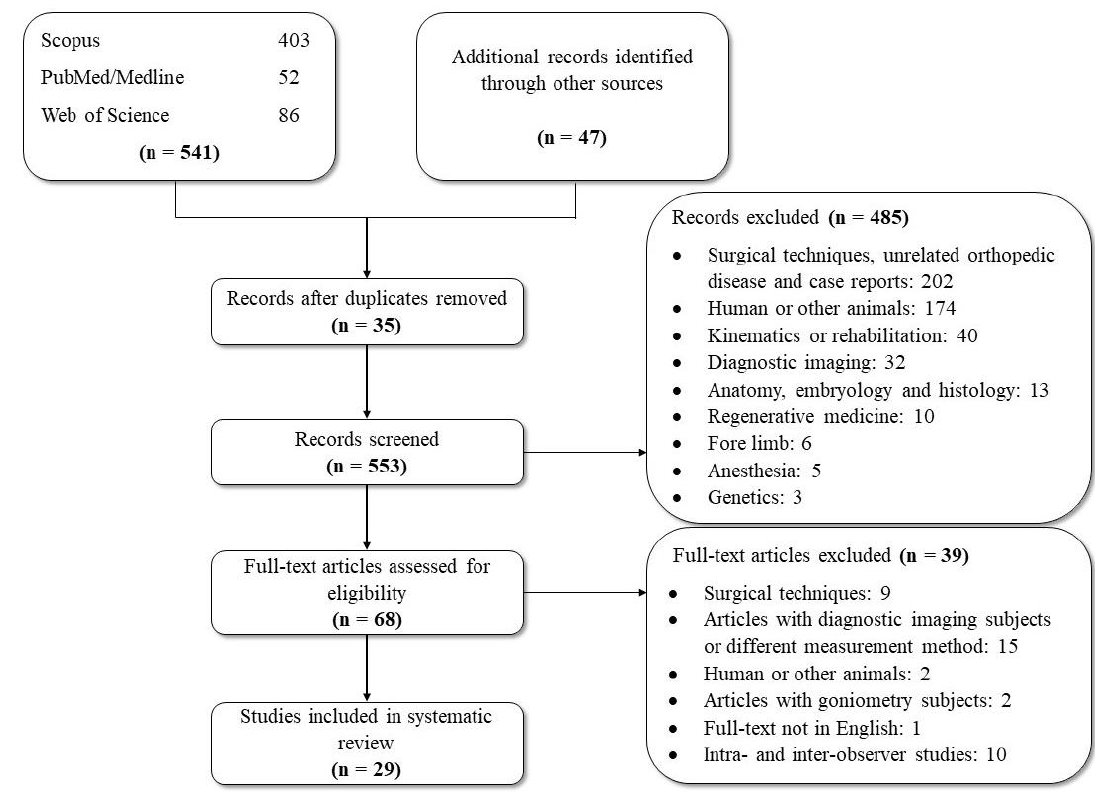
Figure 1. PRISMA [15] flow diagram depicting the number of identified articles and the exclusion process.